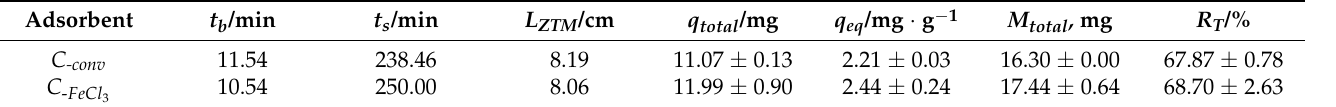
Table 3. Evaluation parameters of the fixed-bed column packed with C -conv and C - FeCl adsorption process of Red G in the influent solution.